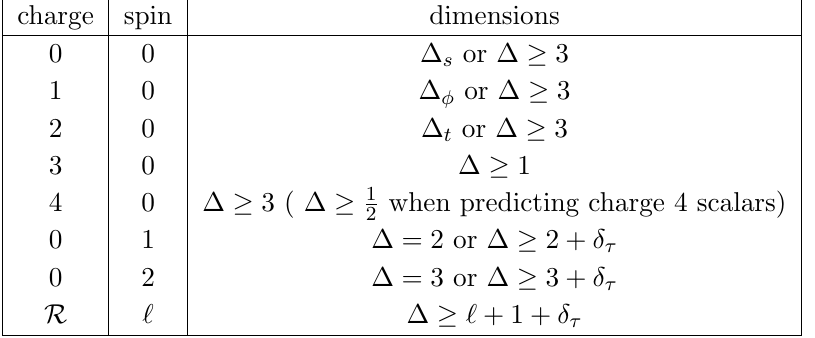
Table 3 . Assumptions about the spectrum of the O(2) model when doing the numerical bootstrap. R ; ‘ represent any other choices of representation R and spin ‘ . In this work we set (cid:14) (cid:28) = 10 (cid:0) 4